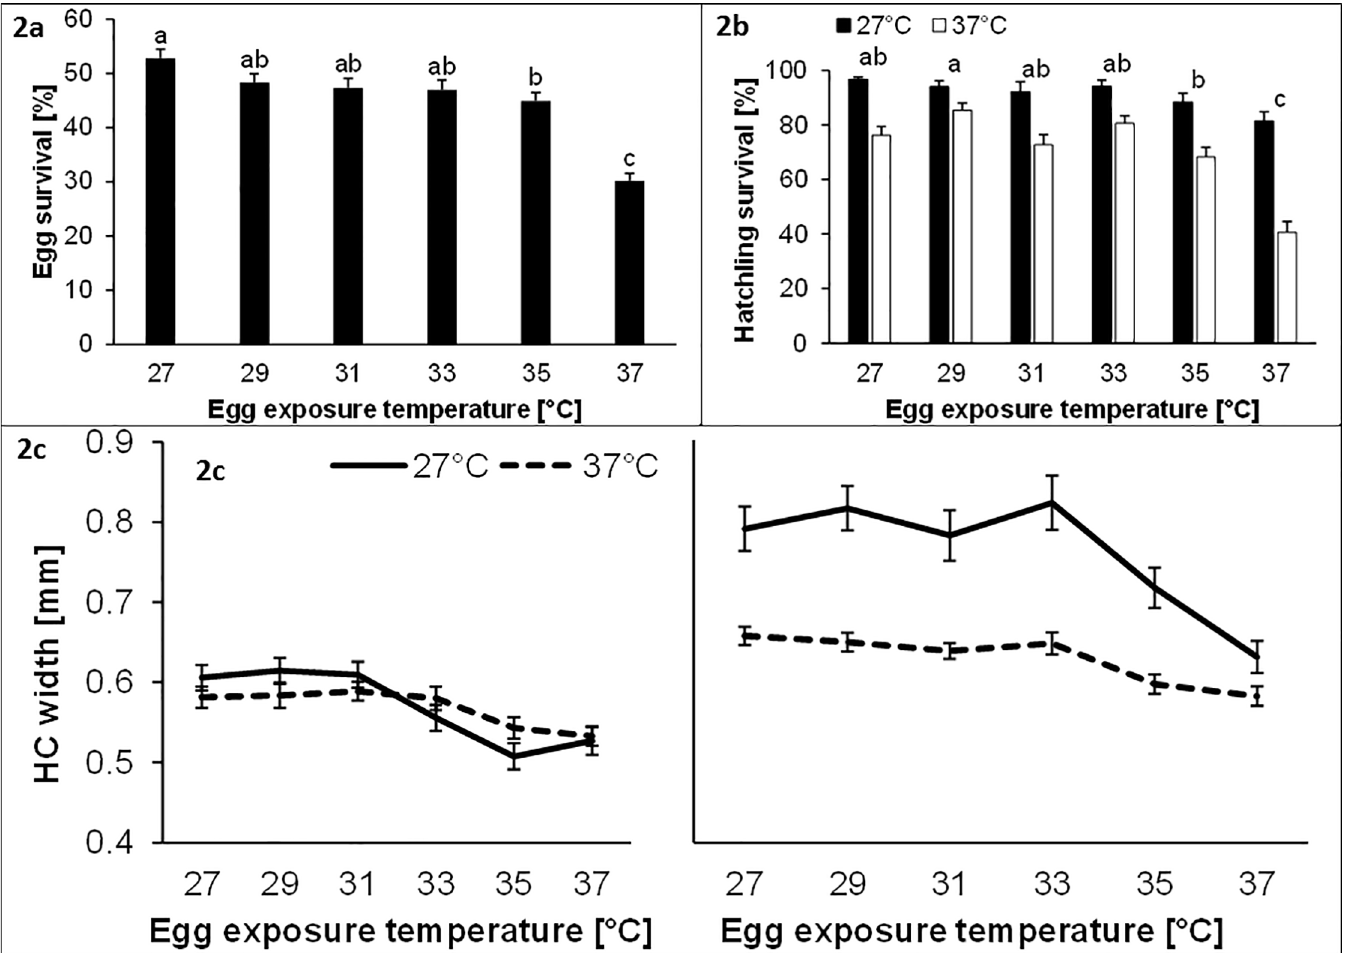
Fig 2. Egg survival rates in relation to temperature(a; 24 h at 27, 29, 31, 33, 35 or 37˚C), hatchlingsurvival rates in relationto egg temperature and heat stress (b; exposure of hatchlings for 24 h to 27˚C or 37˚C), and head capsule(HC) width in relationto egg temperature and heat stress for dead and alive individuals (c) in Bicyclus anynana . Given are means ± 1 SE. Sample sizes range between132 and 199 groups(a), 23 and 55 groups(b), and 6 and 55 groups(c) with 10 individualseach. Different lower case letters abovebars indicatesignificantdifferencesamong egg temperatures (Tukey’s HSD for unequal sample